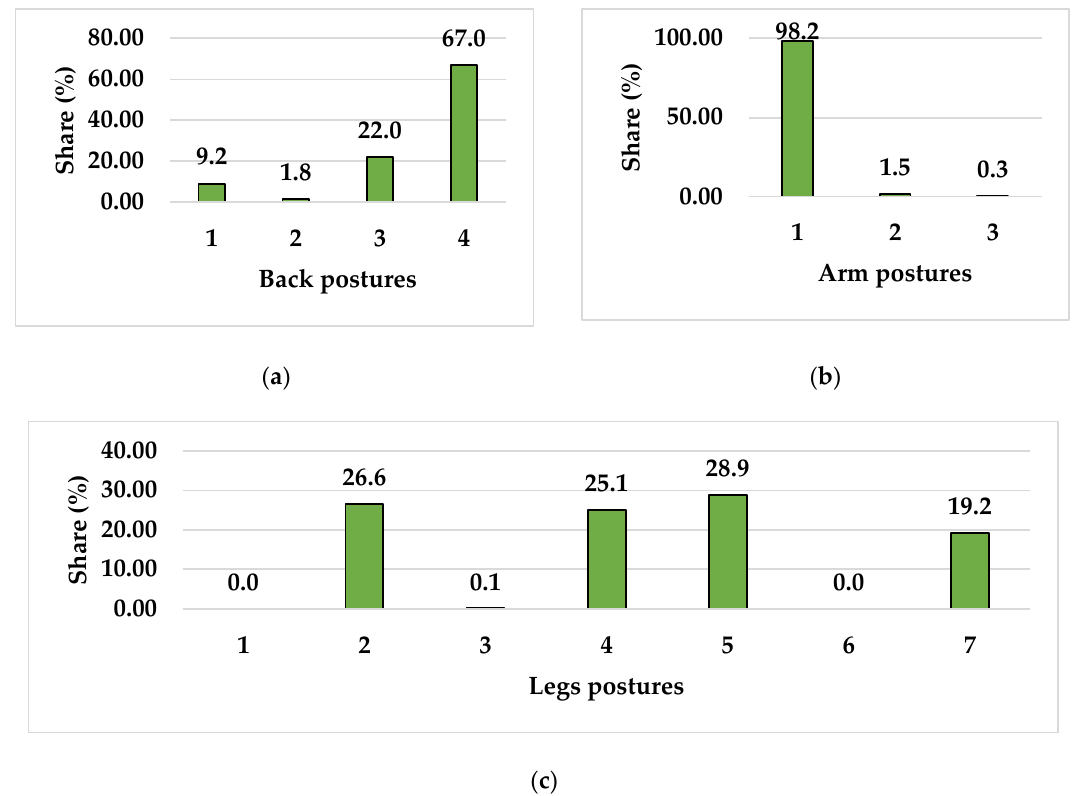
Figure 5. Shares of main body segment postures: ( a ) Back postures; ( b ) Arm postures; ( c ) Leg postures.